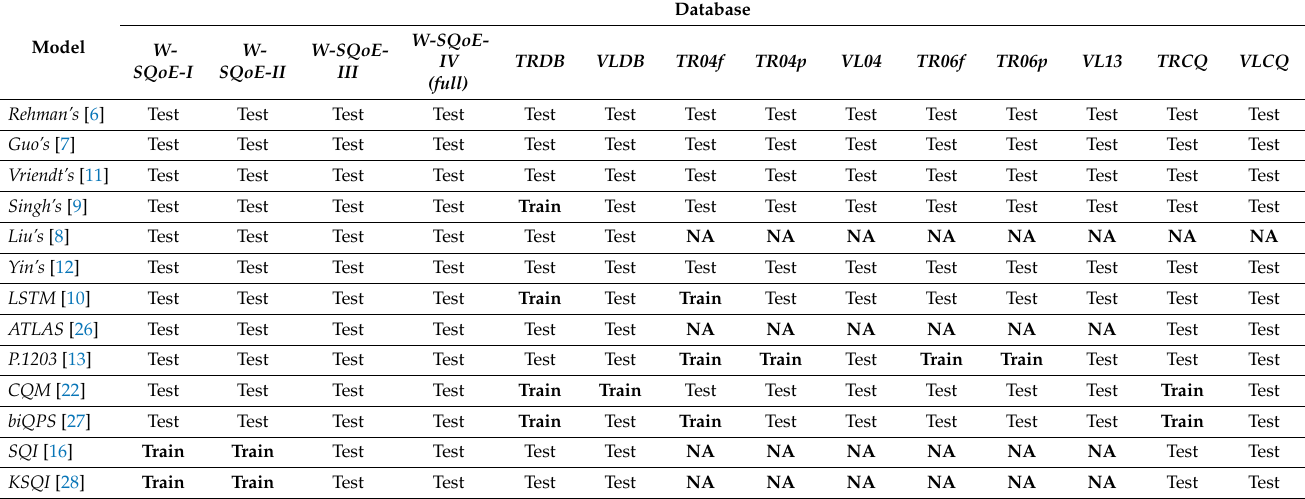
Table 3. Evaluation setting of the databases corresponding to each model. NA: Not